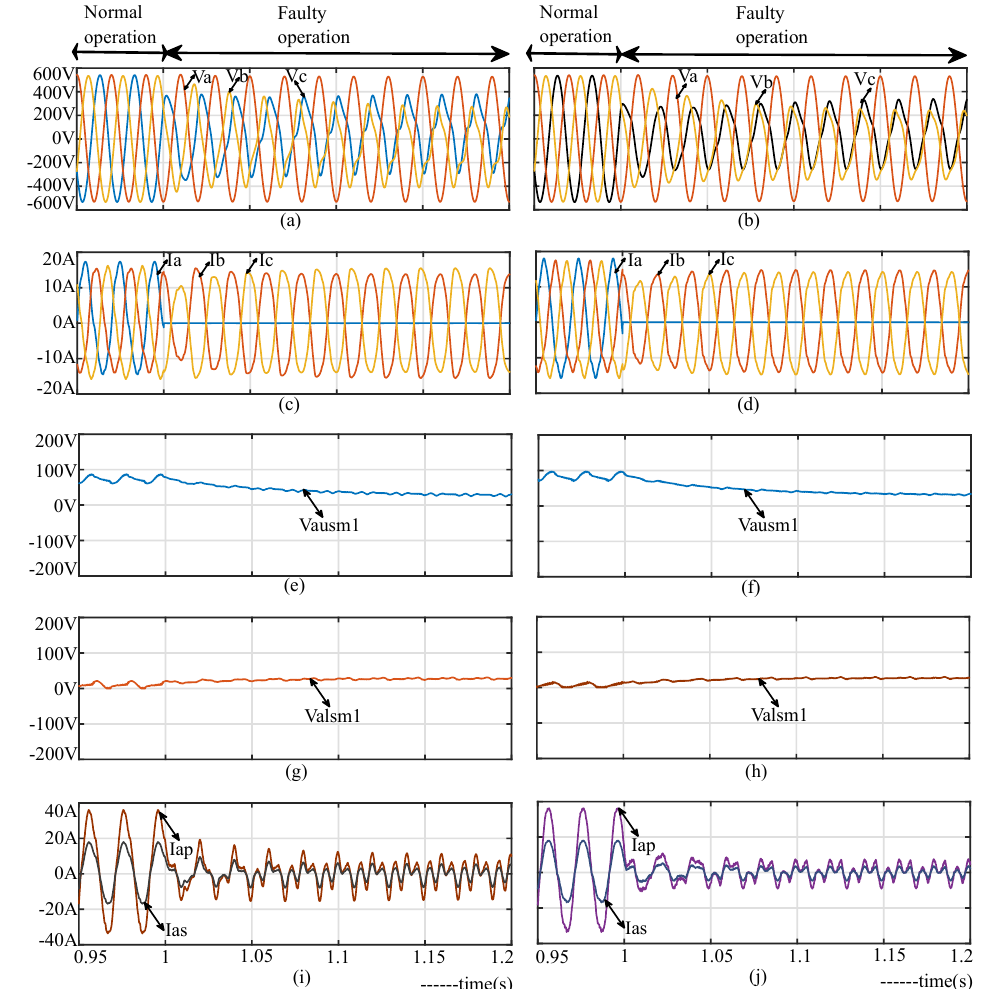
Figure 13. Converter when one phase is open circuited. ( a ) Line voltages of converter with d-q control and STHILSC, ( b ) line voltages of converter with d-q control and STHIPSC, ( c ) line currents of converter with d-q control and STHILSC, ( d ) line currents of converter with d-q control and STHIPSC, ( e ) STHILSC implemented upper arm phase-a SM-1 capacitor voltage, ( f ) STHIPSC implemented upper arm phase-a SM-1 capacitor voltage, ( g ) STHILSC implemented lower arm phase-a SM-1 capacitor voltage, ( h ) STHIPSC implemented lower arm phase-a SM-1 capacitor voltage, ( i ) primary and secondary phase-a transformer currents when STHILSC is implemented, ( j ) primary and secondary phase-a transformer currents when STHIPSC is